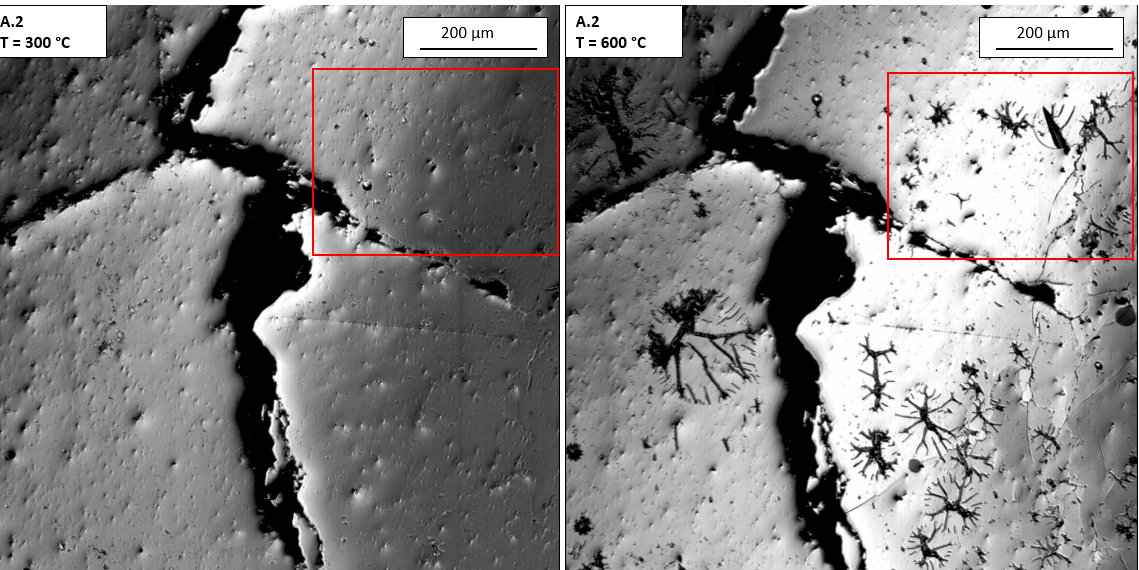
Figure 7. Images from high temperature confocal microscope (HTCM) experiment for A.2 at 300 °C and 600 °C, showing crack formation from cavities from escaped fluid inclusions.